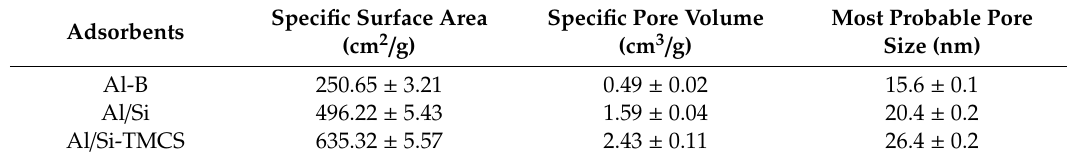
Table 2. Microstructure parameters of the